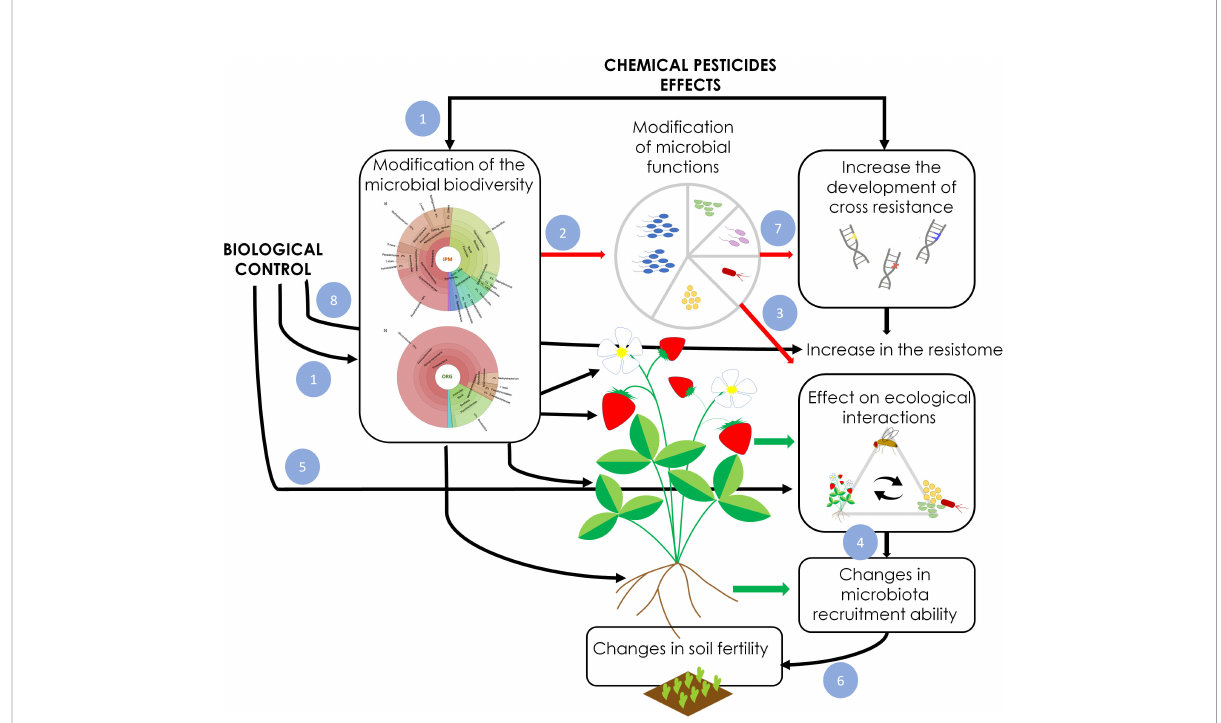
FIGURE 2 Effects of pesticides and biological control application on the phytobiota. Black and red arrows indicate direct and indirect effects, respectively. The green arrow highlights plant-mediated effects. Both pesticides and biological control agents directly modify (1) the structure of the plant- associated microbial communities of fl ower, fruit, leaves, root and endosphere. The modi fi cations of phytobiota structure and composition leads to changes (2) in microbial functions which directly affect plant fi tness, resistance and phenotype. Moreover, the shifts in microbial functions in fl uence plant ecological interactions (3), including the interplay with pests and pollinators (Liu et al., 2019). Since phytobiota composition and functionality is in fl uenced by the exchange of microbes vectored by other organisms [e.g. pollinators (Keller et al., 2021) and pests (Humphrey and Whiteman, 2020)], pesticides use and biological control in fl uence the plant ability to recruit bene fi cial microbes (4). These effects are also mediated by the plant which responds to the changes in the phytobioma by producing different signaling molecules (e.g. VOCs, root exudates) (Park and Ryu, 2021). The application of biological control agents directly in fl uences these mechanisms (5). The changes in the phytobiota, the ecological interactions and the recruitment of bene fi cial microbes affect soil fertility (6), which may further amplify the long- term effects on phytobiota, plant fi tness, production and fruit quality. Finally, the pesticide and biological control application may facilitate the selection of broad resistance against antimicrobial compounds (7) which may result in an expansion of the microbial resistome with detrimental effects on human health. Finally, the application of microbial biological control agents, introducing alien microorganisms, may facilitate the horizontal transfer of new genes with the native microbiome directly in fl uencing the expansion of the resistome